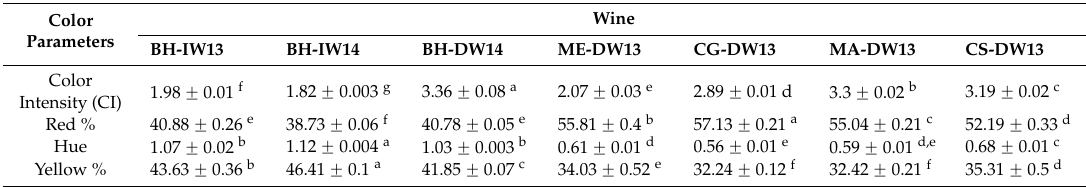
Table 2. Color parameters of the seven trial